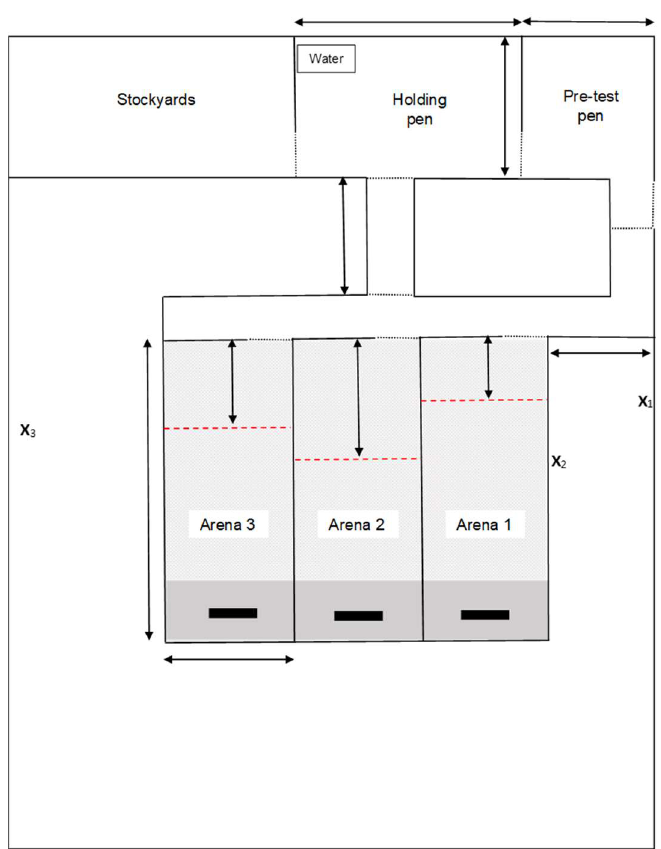
Figure 2. Layout of the associative learning test arena. Use of the three test arenas rotated per training session. Collars were fitted in the stockyards. Individual heifers were removed from the pre-test pen for testing and housed in the holding pen after testing. The exclusion zone was set at a different length for each test arena as indicated by the red dashed line (---). The placement of feed attractant is indicated by black rectangles ( ▬ ) . Gates are represented by a dotted line ( ⸱⸱⸱ ). Pasture was mown for the first 90% of each arena ( ) leaving longer pasture as an additional attractant at the far end ( ). The position of video cameras and of the researcher responsible for administering the audio and electrical stimuli are indicated by X 1 , X 2 and X 3 for arenas 1, 2 and 3 respectively.